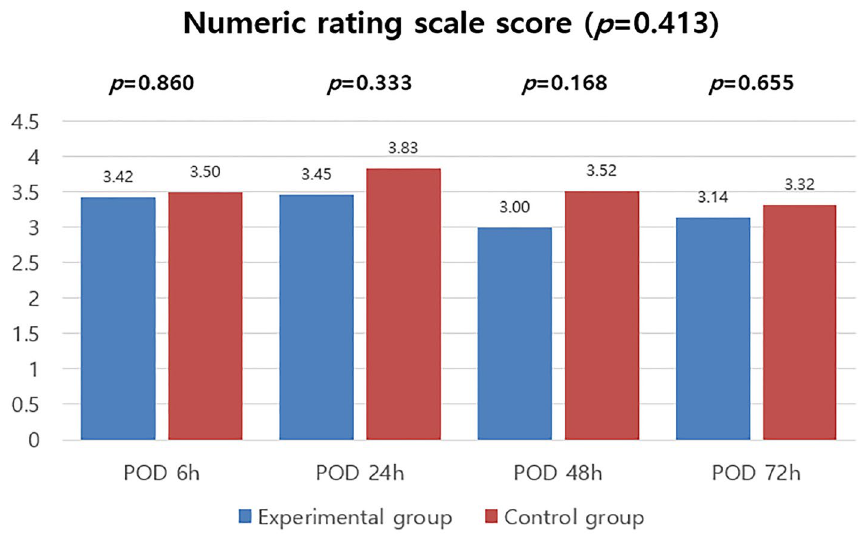
Figure 4. Numeric rating scale scores.